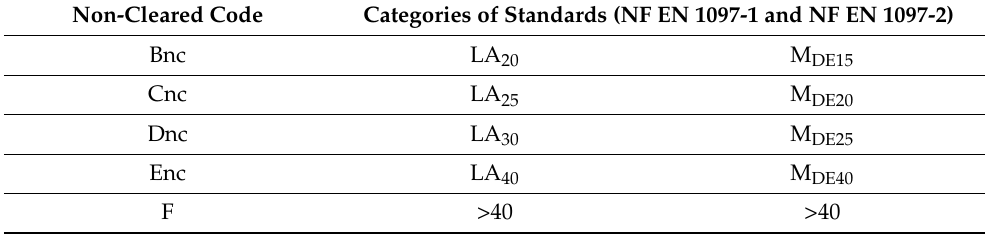
Table 7. LA and M DE (uncompensated) category codes for foundation, base and binder